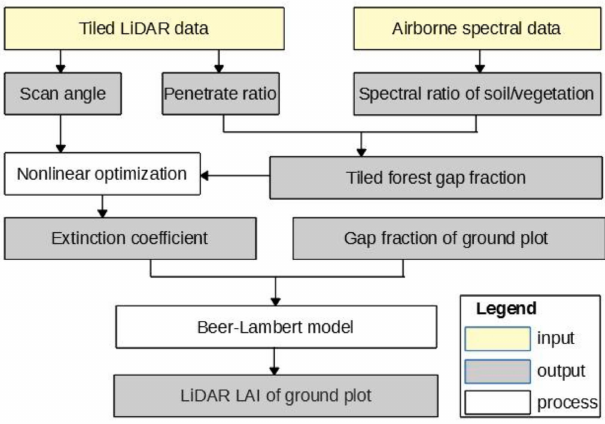
Figure 3. Flowchart of the